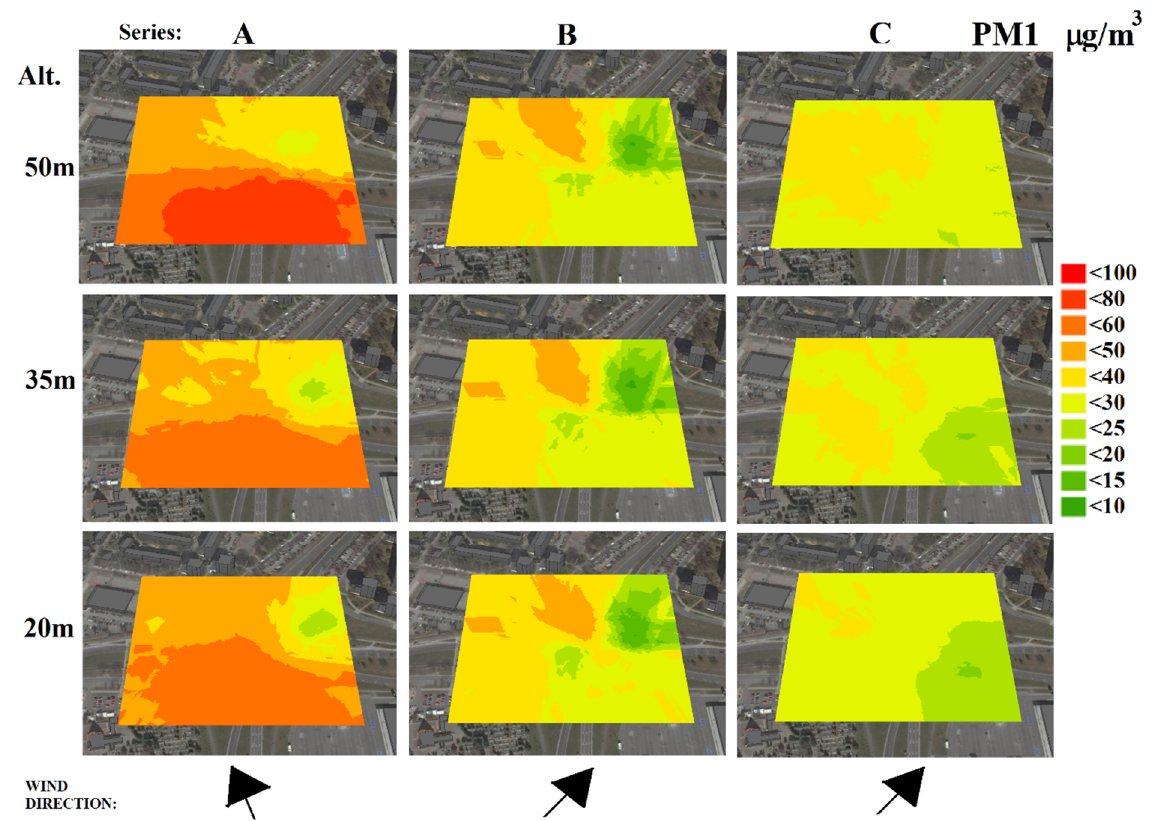
Figure 11. Spatial distribution of PM 1 . 0 pollution at the altitude of 20, 35 and 50 m for three measurement series in the area of the street intersection.